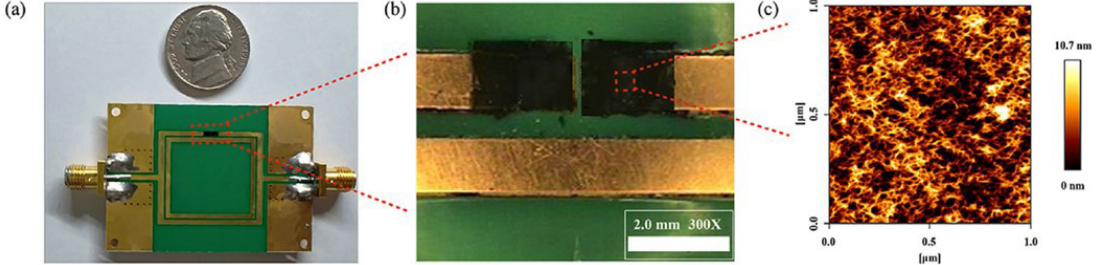
Figure 14. Characterization of the DSRR-based relative humidity sensor with PEDOT:PSS. ( a ) Photograph of the fabricated sensor. ( b ) Optical microscope image of the sensing region. ( c ) 2D AFM image of the PEDOT:PSS surface [95].